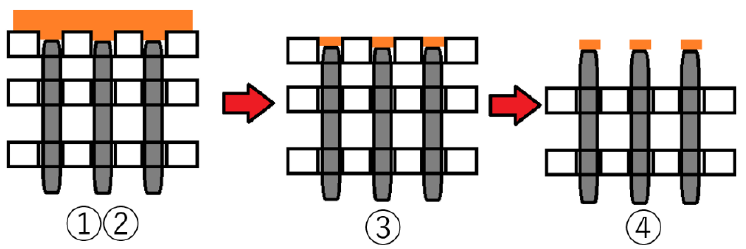
Figure 11. Procedure of pasting adhesive material on each pin. 1 (cid:79) Place the insertion plate over the pin magnet, 2 (cid:79) coat with an adhesive sample, 3 (cid:79) remove excess adhesive samples, and 4 (cid:79) remove the insertion plate.